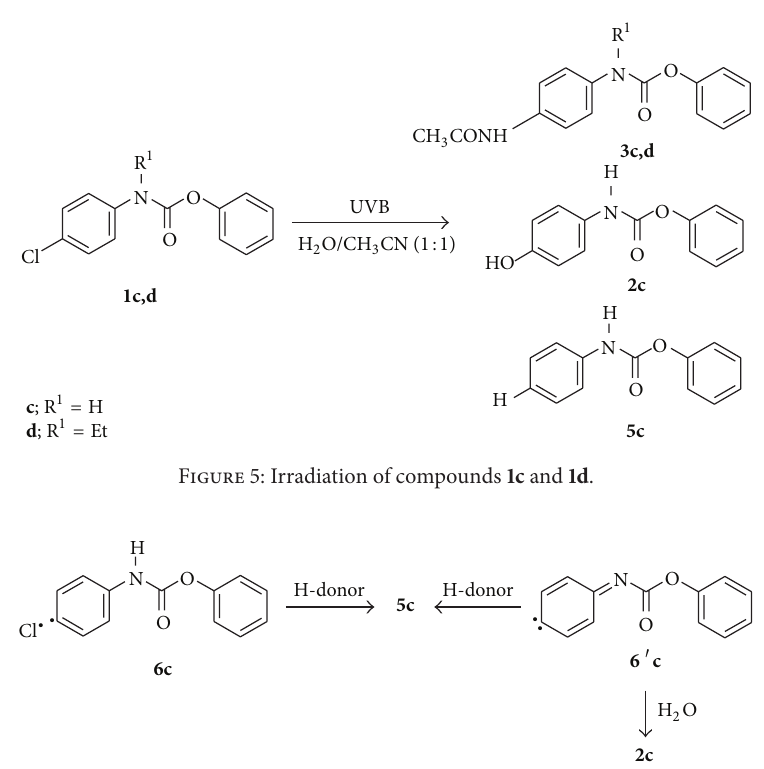
Figure 6: Suggested intermediates for the photoproducts 5c and 2c